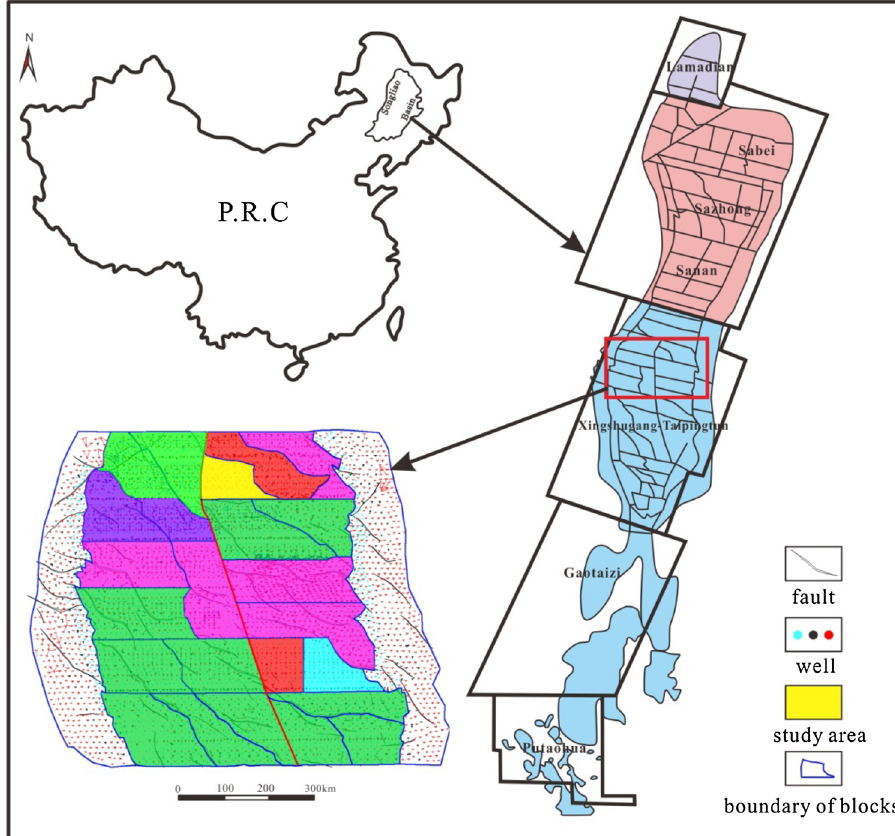
Fig. 1 The regional geographic location map of the study